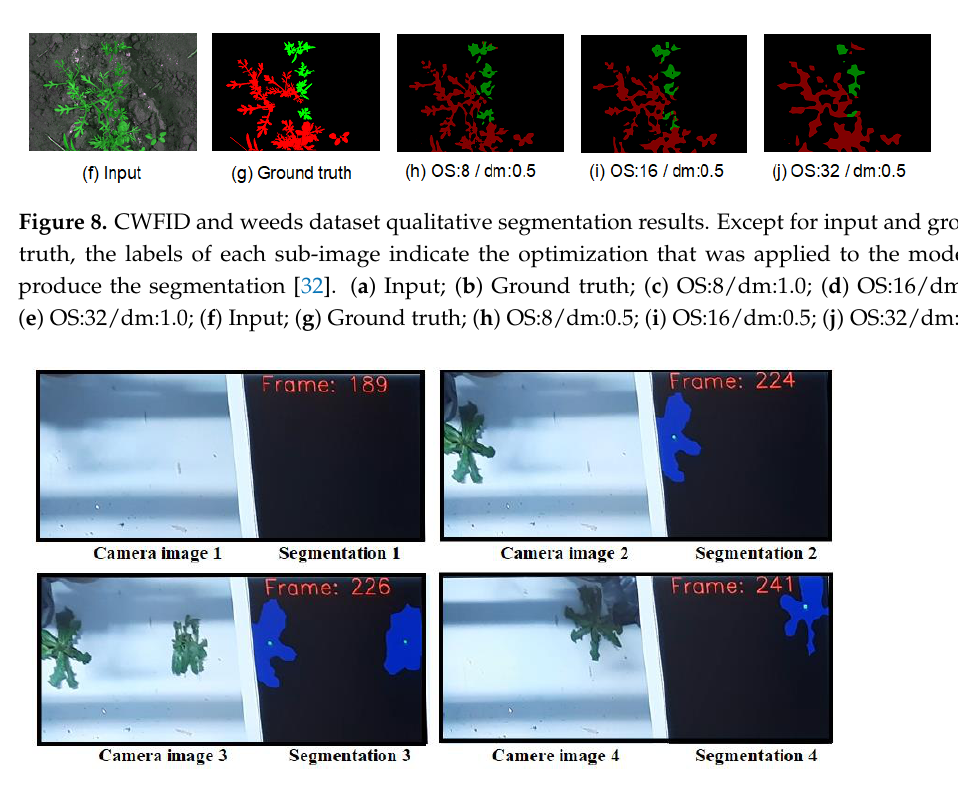
Figure 9. Segmentation of weeds as result of the application in real time [32].